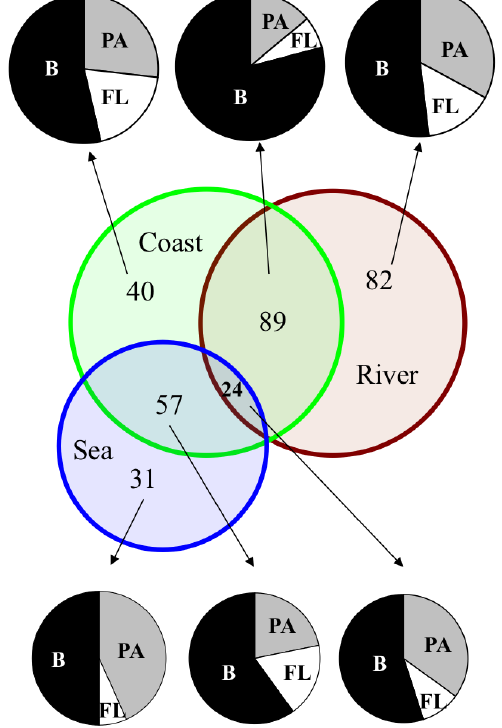
Fig. 4. OTU distribution between open sea (blue circle), coast (green circle) and river (brown circle) (areas are proportional to the number of OTUs). Relative abundance of all exclusive and shared OTUs in the particle-attached fraction (PA), in the free-living frac- tion (FL) or in both fractions (B) is also shown.